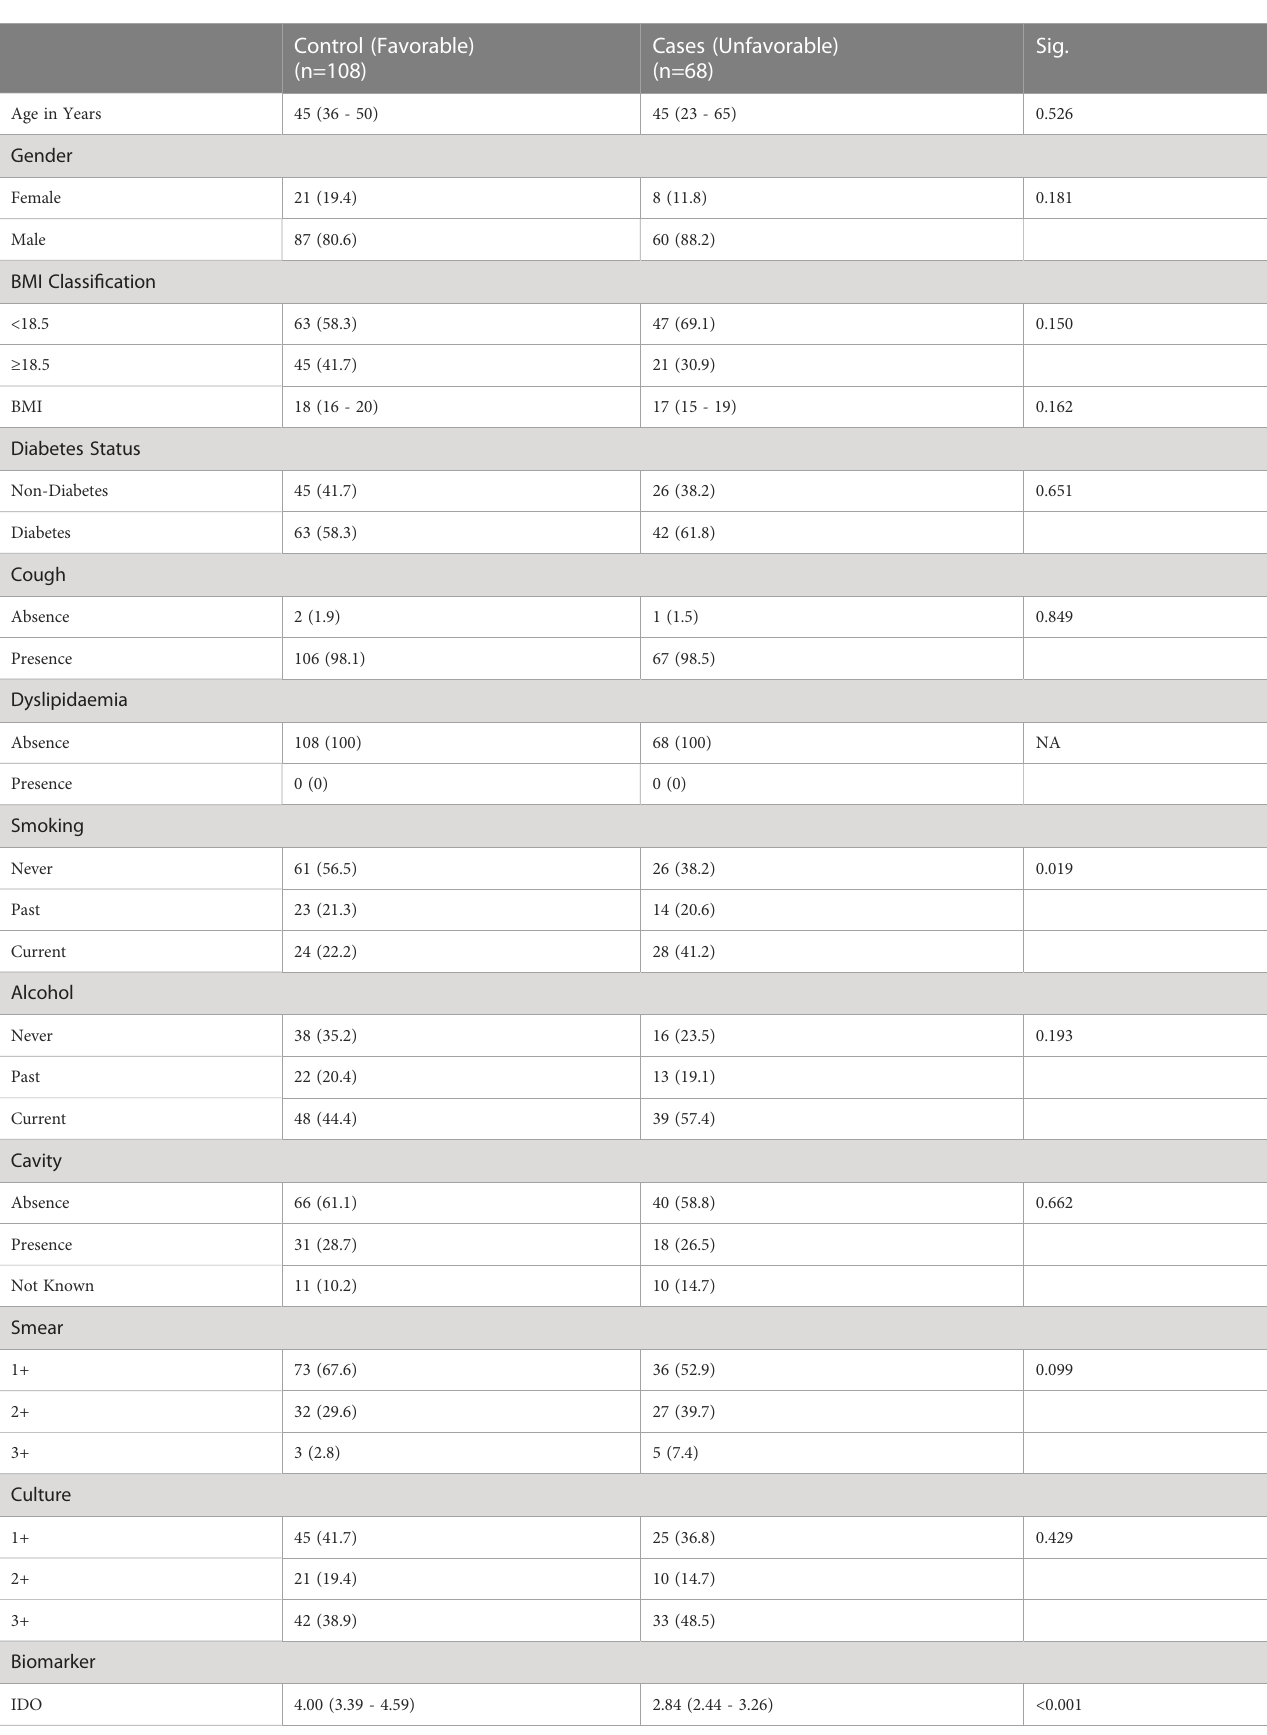
TABLE 1A Patients characteristics for individuals with TB treatment Outcome. Control (Favorable)